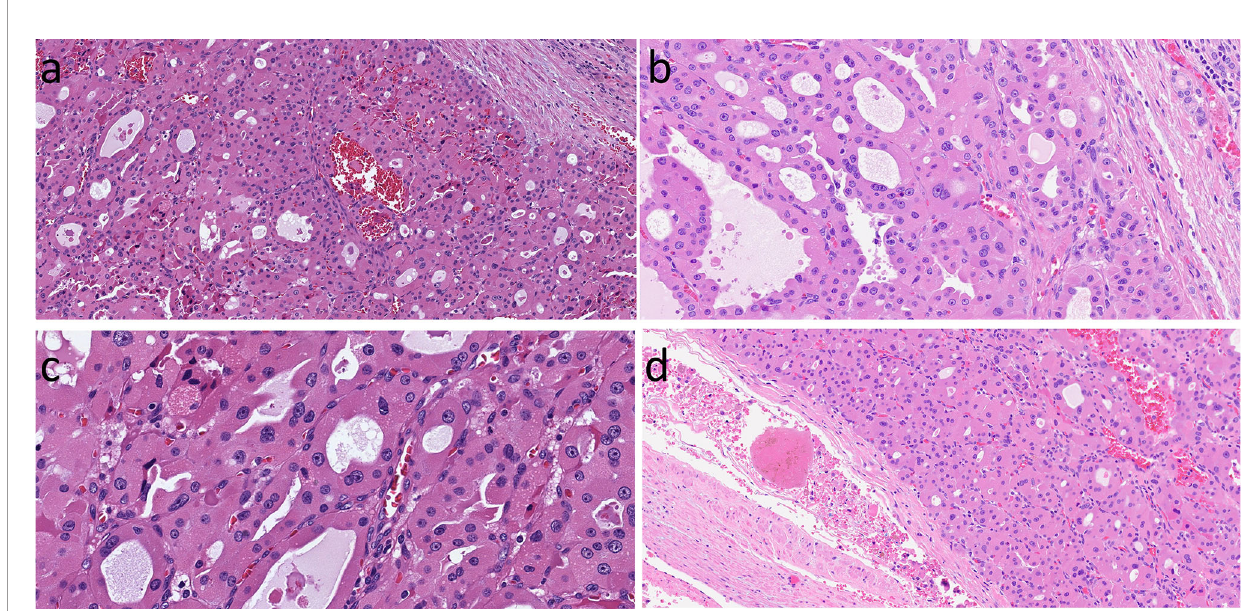
FIGURE 5 | Oncocytic Follicular-Patterned Differentiated Thyroid Carcinoma. Follicular neoplasms composed of oncocytic follicular cells can exhibit local invasion into the tumor capsule (A) . They may have nuclear atypia including irregular contours, moulding, clearing of nucleoplasm and grooves (B, C) in addition to the prominent nuleoli of oncocytic cells. There may be lymphatic invasion that is associated with regional lymph node spread (not shown) and/or vascular invasion with associated intravascular thrombus (D) that predicts systemic